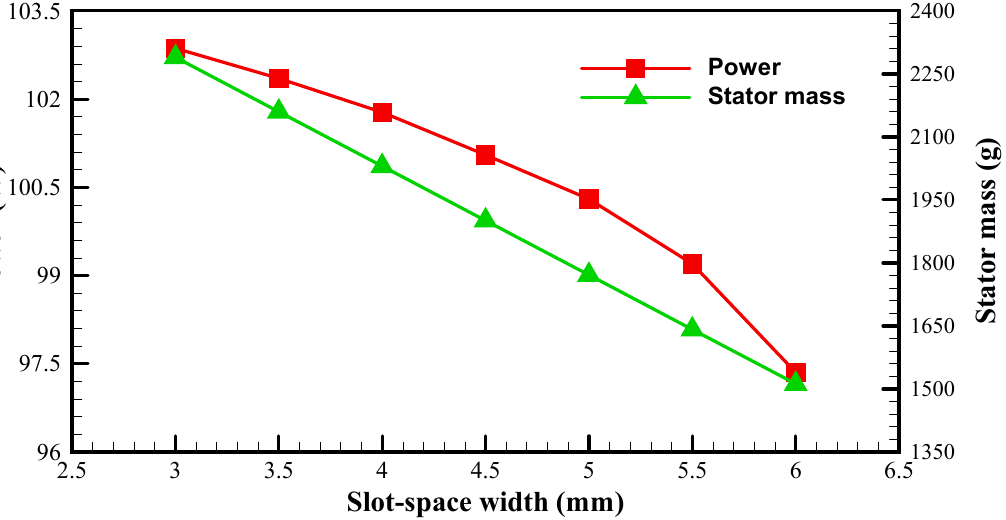
Figure 14. Influence of slot-spacing on power and stator mass.